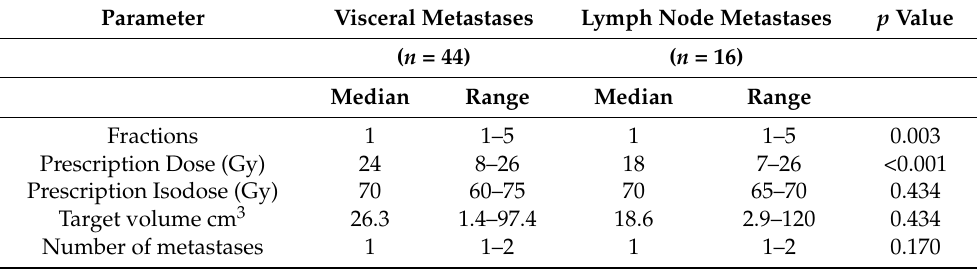
Table 2. Robotic radiosurgery treatment